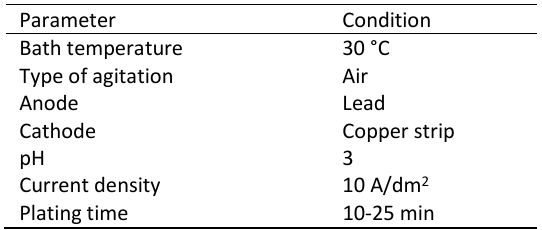
Fig.1 . Representation of a) Filter membrane made of copper b) Ni-Cr alloy coated membrane and c) oil particulates entangled in filter membrane. Plating parameters for varying current density in nickel- chromium plating at constant current